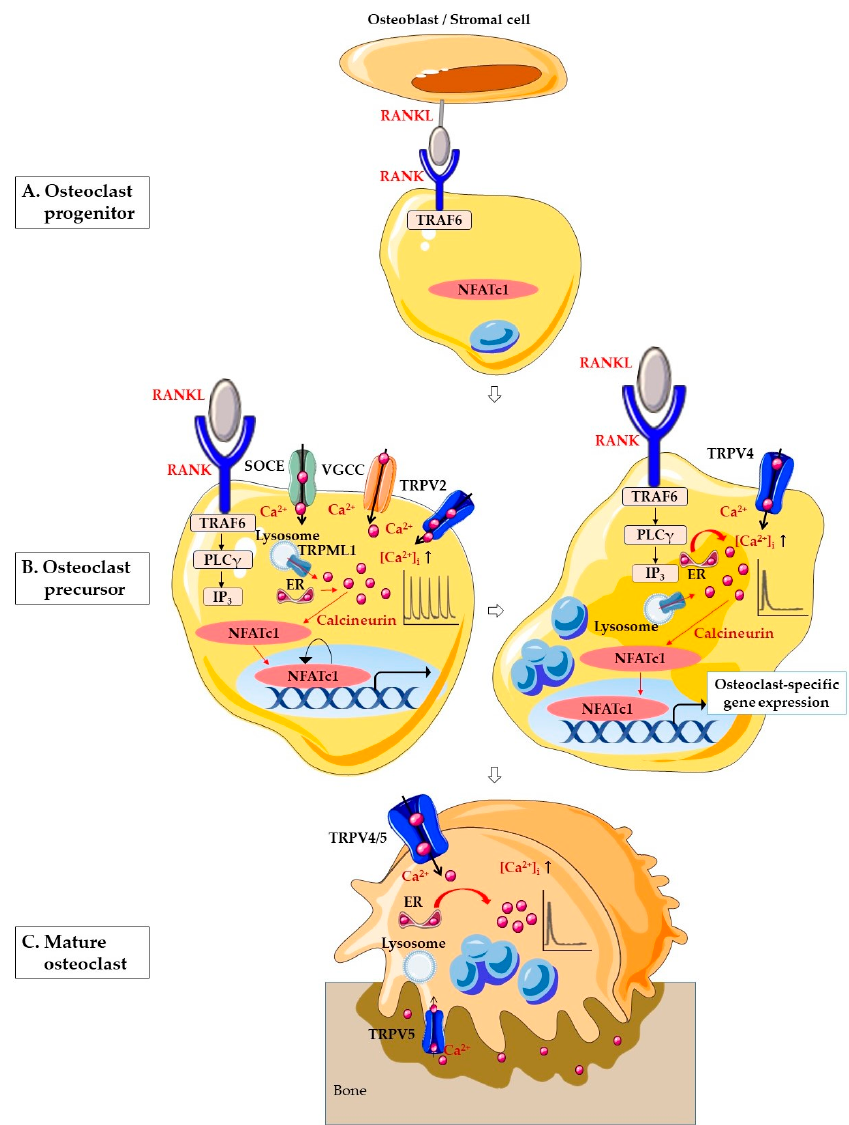
Figure 1. Schematic illustration of Ca 2 + signaling in osteoclastogenesis. ( A ) RANK on the surface of osteoclast progenitor activates signaling by RANKL on the surface of osteoblasts / stromal cell to promote osteoclastogenesis. ( B ) Osteoclast precursor stage. In the early stages of osteoclastogenesis, RANK-bound RANKL induces activation of TRAF6 and stimulates PLC γ . PLC γ produces IP 3 , which evokes Ca 2 + release from the ER. In addition, RANK-bound RANKL induces lysosomal Ca 2 + release through TRPML1 and generates Ca 2 + oscillation. SOCE, VGCC and TRPV2 are also involved in Ca 2 + oscillation. The Ca 2 + oscillations induce Ca 2 + -calcineurin-NFATc1 signaling. In the late stages of osteoclastogenesis, the Ca 2 + oscillation is sustained by TRPV4-mediated Ca 2 + influx. In the nucleus, NFATc1 induces the expression of various osteoclast-specific genes. ( C ) In mature osteoclasts, TRPV4 and TRPV5 in the basolateral membrane are necessary for the regulation of osteoclastic bone resorption. TRPV5 is predominantly located on the ru ffl ed border of resorbing osteoclasts. Abbreviations: RANKL, receptor activator of nuclear factor- κ B (NF- κ B) ligand; RANK, receptor activator of nuclear factor- κ B (NF- κ B); NFATc1, nuclear factor of activated T cells cytoplasmic 1; TRAF6, tumor necrosis factor (TNF) receptor-associated factor 6; PLC γ , phospholipase C γ ; IP 3 , inositol 1,4,5-triphosphate; ER, endoplasmic reticulum; Ca 2 + , calcium; [Ca 2 + ] i , intracellular Ca 2 + concentration; SOCE, store-operated Ca 2 + entry; VGCC, voltage-gated Ca 2 + channel; TRPV2, transient receptor potential vanilloid 2; TRPV4, transient receptor potential vanilloid 4; TRPV5, transient receptor potential vanilloid 5; TRPML1, transient receptor potential mucolipin